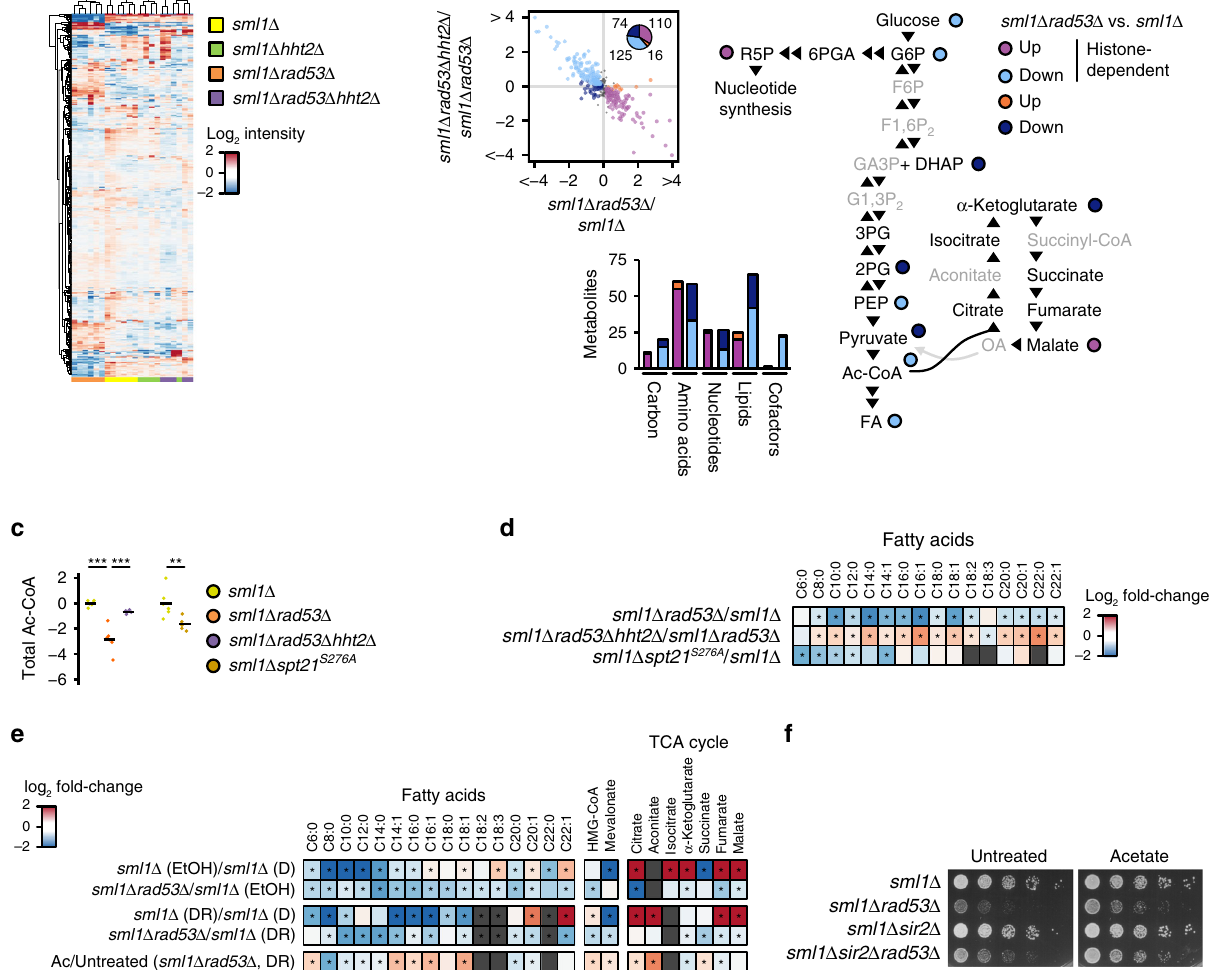
(Fig. 6e, Supplementary Fig. 9a, b), and Ac-CoA levels were below the detection limit. Deletion of RAD53 further enhanced the depletion of Ac-CoA-derived fatty acids, reduced the level Ac- CoA-derived sterol precursors, and reduced the accumulation of a subset of TCA metabolites (Fig. 6e).